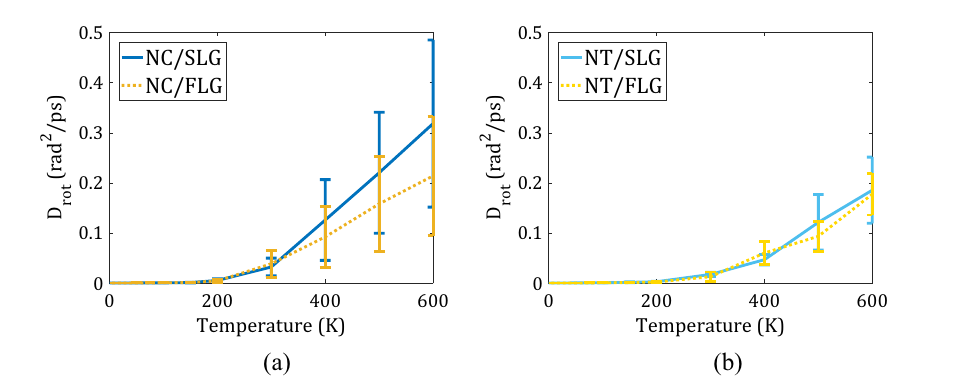
Figure 8. Rotational diffusion coefficient of wheels in (a) Nanocar and (b) Nanotruck as a function of temperature. Wheels in flexible Nanocar rotate more easily than in